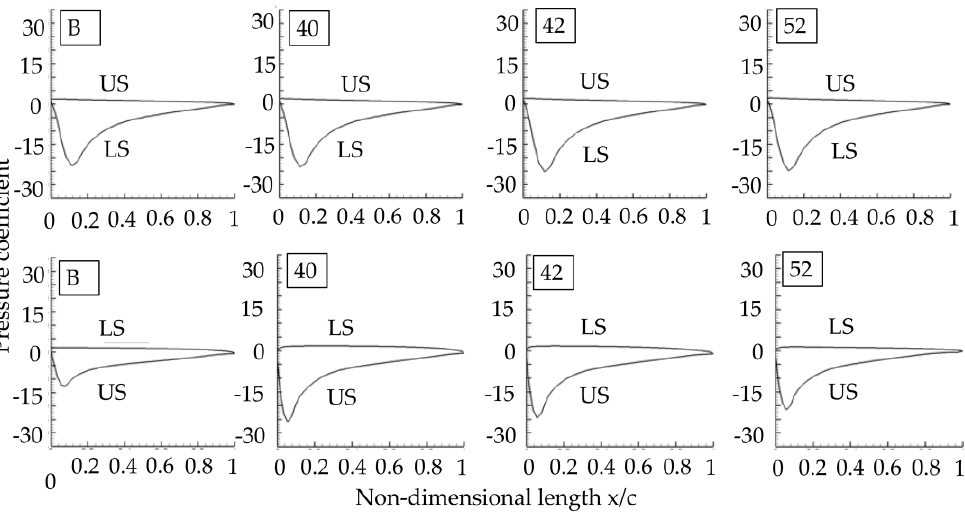
Figure 21. Comparison of surface pressure coefficient on the upper surface (US) and lower surface (LS) around the oscillating hydrofoil for different tilt angles of the upstream deflector (first row: t/T = 0.2; second row: t/T = 0.65). Table 3. Relationship between C P and flow field for the nine analyzed cases (R: Reduced, I: Increased, C: Constructive, D: Destructive, X: No effect; tick mark represents the existence of